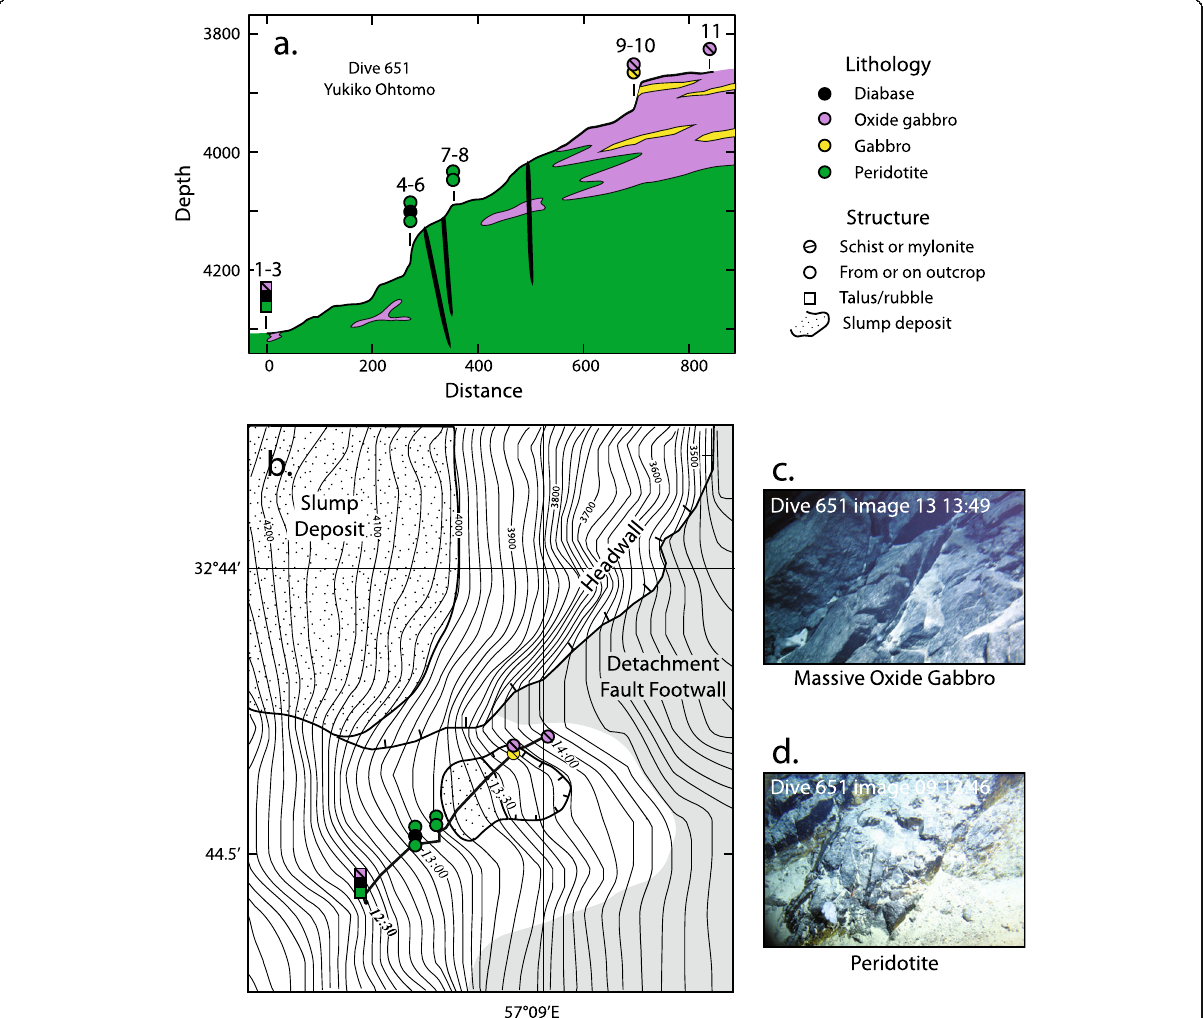
Fig. 37 Shinkai 6500 Dive 651 (Fig. 3) profile and plan view. a Geologic interpretation based on samples, dive observations, and bathymetry. Scientific observer was Yukiko Ohtomo. Highly deformed, C-P grade 2-3 oxide gabbros are intruded into protogranular harzburgite and lherzolite peridotites. b Plan view bathymetry with terrain analysis based on seafloor geomorphology and dive samples. c Massive, jointed oxide gabbro outcrop at 4098 m depth. d Irregularly jointed massive serpentinite outcrop at 4214 m